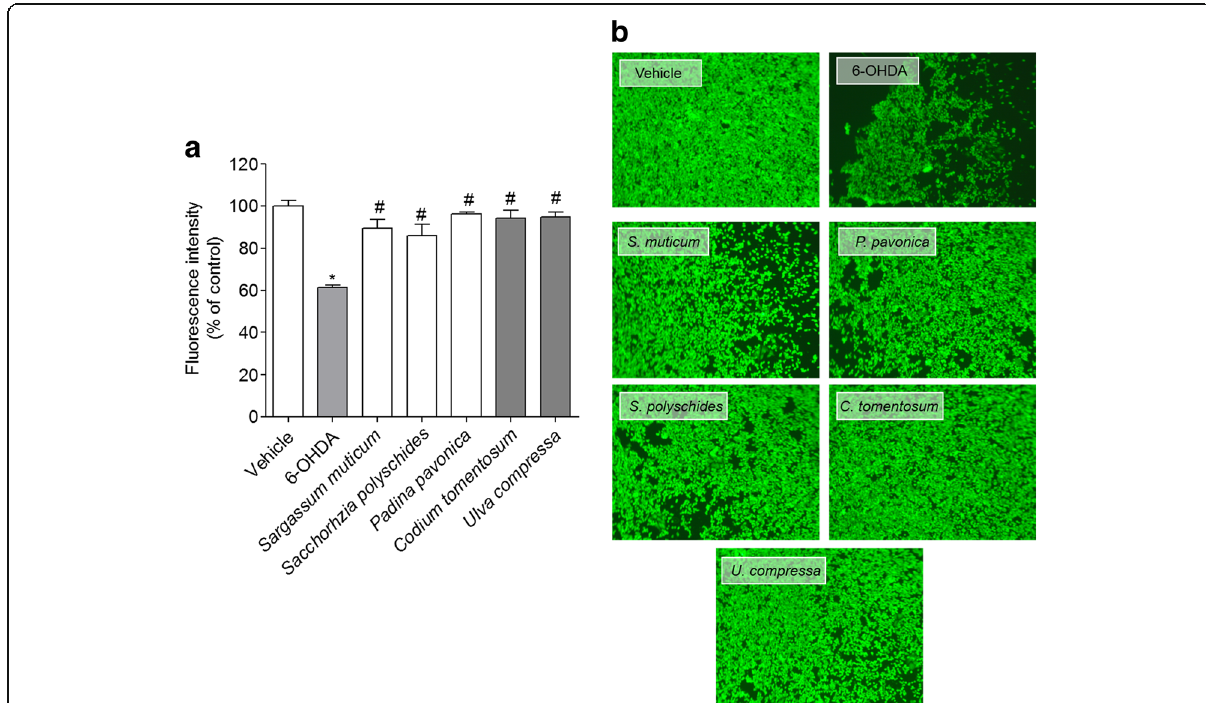
Fig. 3 Neuroprotective effects of seaweeds extracts (1 mg/mL) on SH-SY5Y cells exposed to 6-OHDA (100 μ M) revealed by Calcein-AM method a ) Read of fluorescence (% control) after 24 h of incubation. Values are mean±SEM ( n =8). Symbols represent statistically significant differences ( p <0.05, ANOVA, Dunett ’ s test) when compared to: * vehicle. # to 6-OHDA. b Observation by fluorescence microscopy of the effects induced by 6-OHDA and seaweeds extracts. The images are representative of each treatment done and correspond to the center-point of one well. Methanolic extract: Sargassum muticum , Padina pavonica and Saccorhiza polyschides ; Dichloromethane extract: Codium tomentosum and Ulva